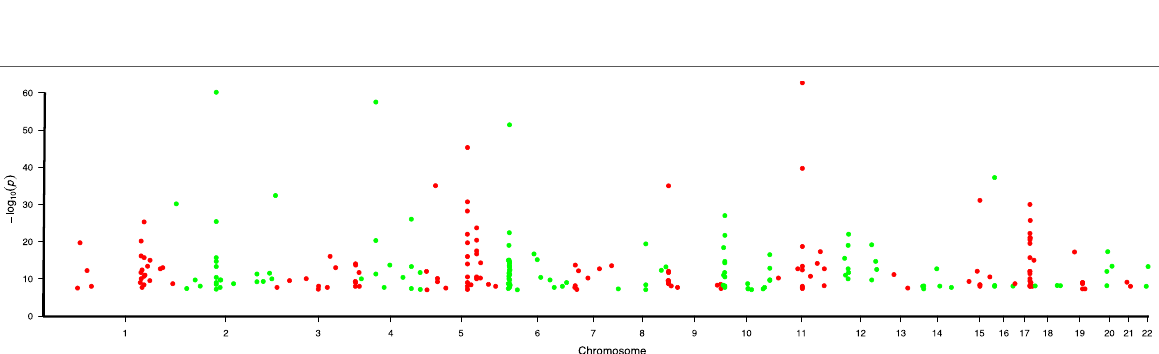
10–8) with asthma/AR in ×